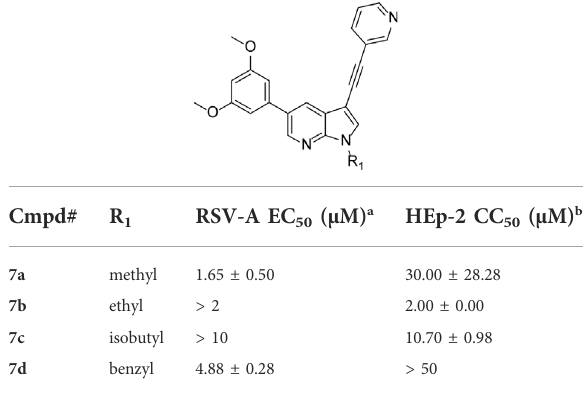
TABLE 4 Anti-RSV activity and cytotoxicity of N-substituted 5-(2,5- dimethoxy)-3-(3-pyridinyl)-pyrrolo[2,3- b